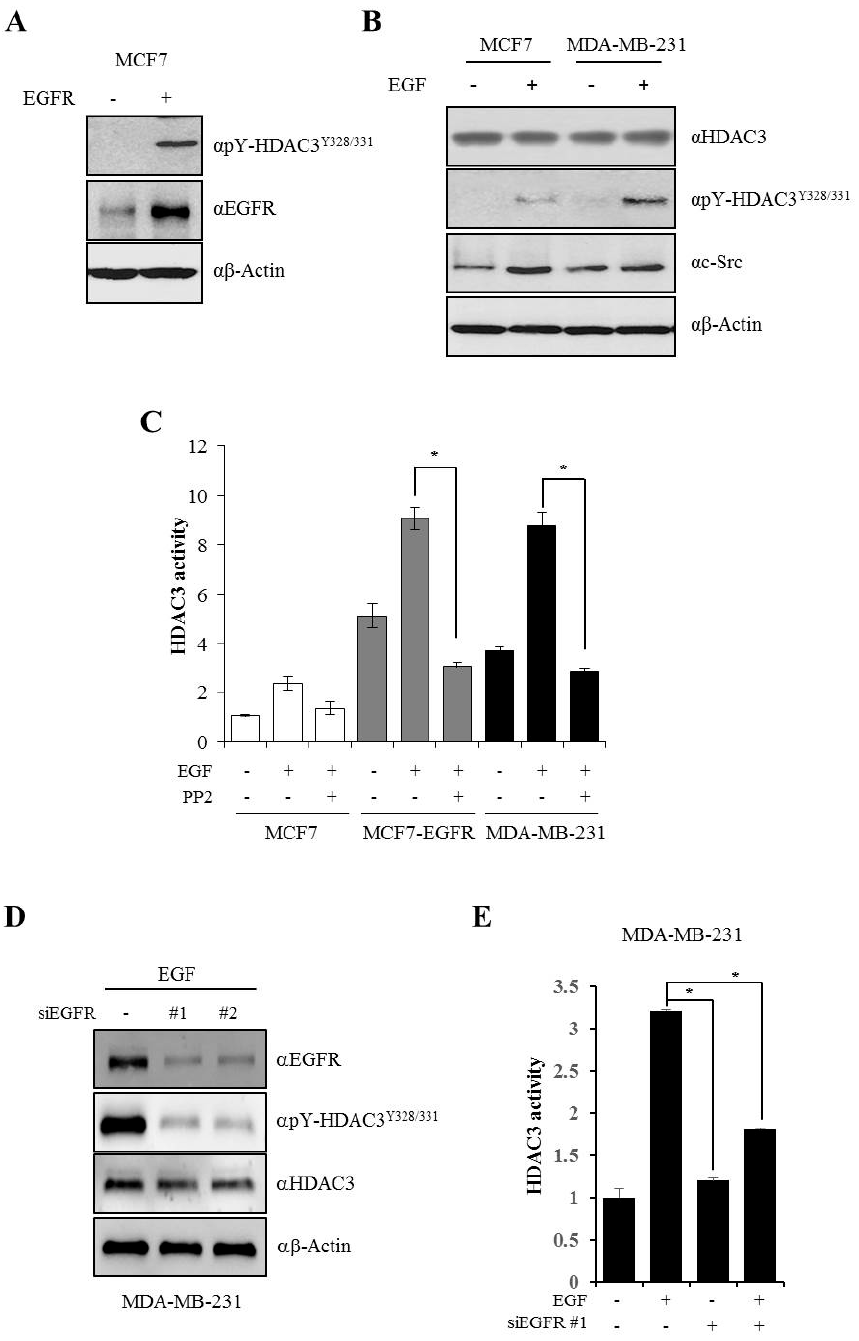
Figure 4. Epidermal growth factor (EGF)-induced c-Src-mediated phosphorylation of HDAC3 is dependent on epidermal growth factor receptor (EGFR). ( A ) EGFR is essential for the phosphorylation of HDAC3. EGFR was transfected into MCF7 cells, and cell lysates were analyzed by Western blotting with indicated antibodies. ( B ) EGF-induced HDAC3 phosphorylation is dependent on EGFR. MCF7 and MDA-MB-231 cells were treated with EGF, and cell lysates were analyzed with indicated antibodies. ( C ) The activation of EGFR signaling is critical for HDAC3 enzymatic activity. Various breast